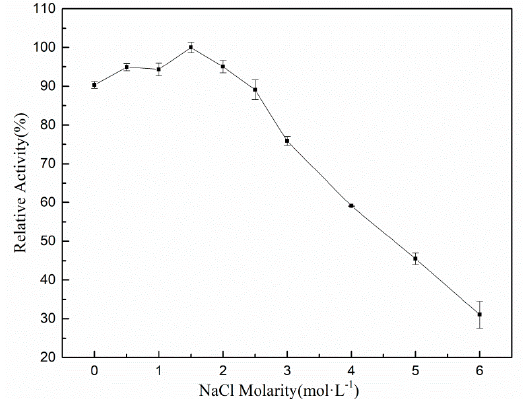
Figure 3. The influences of NaCl on the activity of the Xyl88.